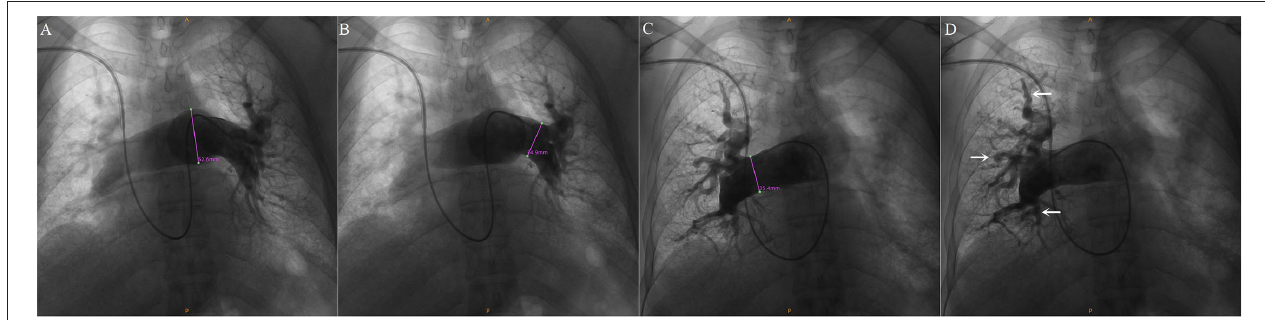
FIGURE 1 | Catheter pulmonary angiogram in a 52-year-old female patient with CTD-PAH. (A–C) Pulmonary angiography showed that the diameter of the pulmonary artery was enlarged. (A) Main pulmonary artery. (B) Left and right pulmonary artery. (C) Right pulmonary artery. (D) Distal pulmonary artery changed into tortuousness